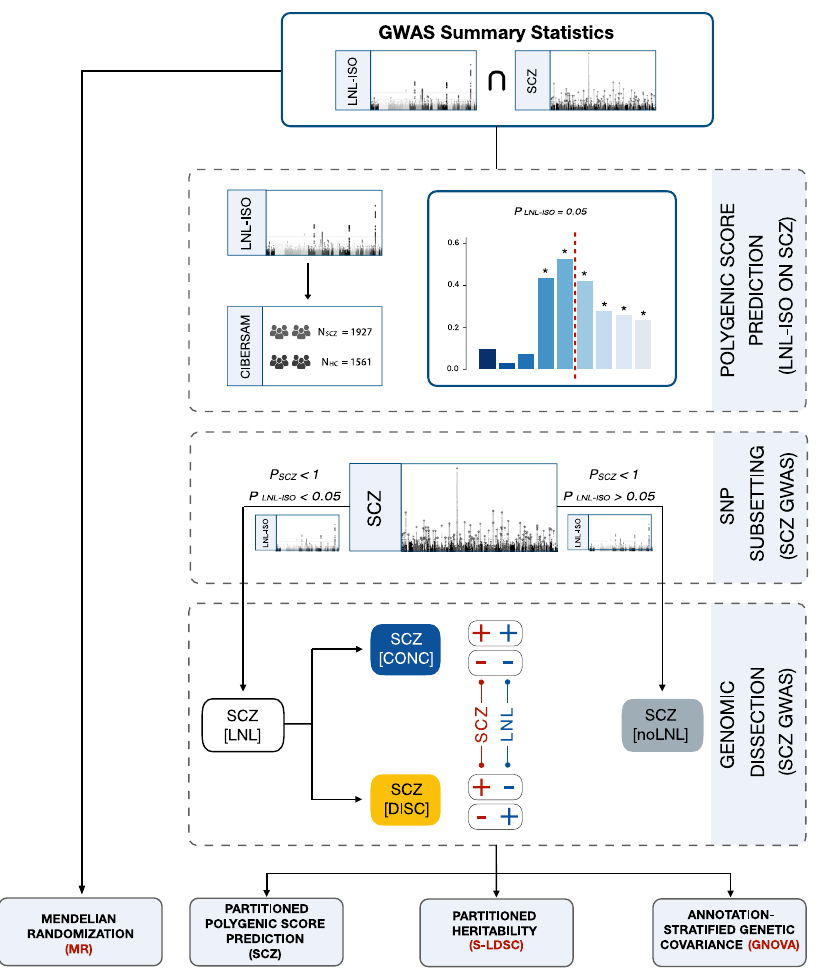
Fig. 1 Work fl ow of the analytic pipeline. GWAS summary statistics from schizophrenia 83 and LNL-ISO 32 were used. We evaluated the LNL-ISO polygenic score (PGS LNL-ISO ) contribution to schizophrenia risk in an independent case-control sample ( N SCZ = 1927; N HC = 1561). Subsequent genomic dissection of schizophrenia GWAS based on LNL-ISO led to different annotations: (i) SCZ[LNL]: variants from the schizophrenia GWAS associated with LNL-ISO ( P LNL- P LNL-ISO < 0.05) and concordant allele effects in both ISO < 0.05), (ii) SCZ[CONC]: variants from the schizophrenia GWAS associated with LNL-ISO ( phenotypes (Beta SCZ > 0 & Beta LNL-ISO > 0 OR Beta SCZ < 0 & Beta LNL-ISO < 0), and (iii) SCZ[DISC]: variants from the schizophrenia GWAS associated with LNL-ISO ( P LNL-ISO < 0.05) and discordant allele effects in both phenotypes (Beta SCZ > 0 & Beta LNL-ISO < 0 OR Beta SCZ < 0 & Beta LNL-ISO > 0), and (iv) (SCZ[noLNL]: variants from the schizophrenia GWAS not associated with LNL-ISO (P LNL-ISO > 0.05); see Methods and Supplementary Methods for further details). We performed PGS analyses, partitioned heritability, and annotation-based strati fi ed genetic covariance analyses across those subsets. We performed Mendelian randomization to evaluate causality between schizophrenia and LNL-ISO (and its constituent traits). “ + ” and “ − ” in the fi gure refer to the direction of the effect of the alleles